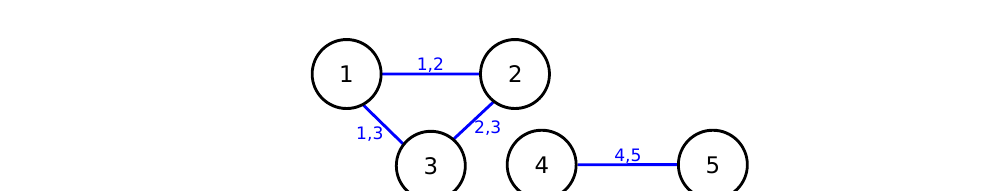
Figure 10: Example: first tree of a non valid vine structure for d = 5 that does lead to a single connected